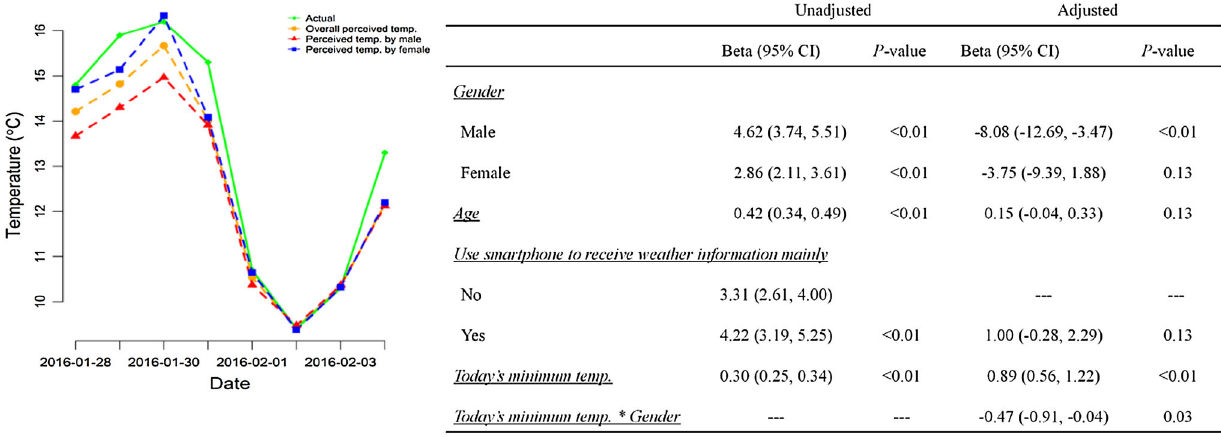
Fig. 3 Factors associated with perceived temperature error in the cold 2016 winter of Hong Kong. Note 1017 valid samples were collected in Hong Kong in January/February 2016; 701 people who